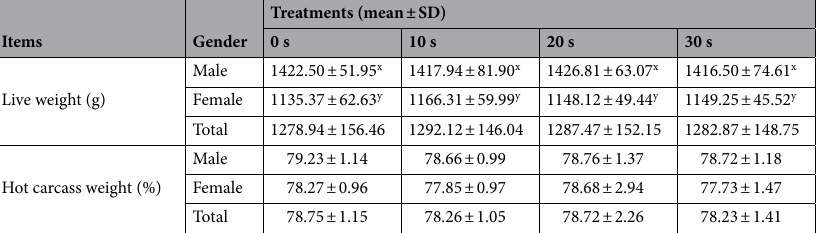
Table 5. Live and hot carcass weights of crossbred Pradu Hang Dam chickens among four treatments. x,y Values with different superscript letters in a row are significantly different (p-value < 0.05).